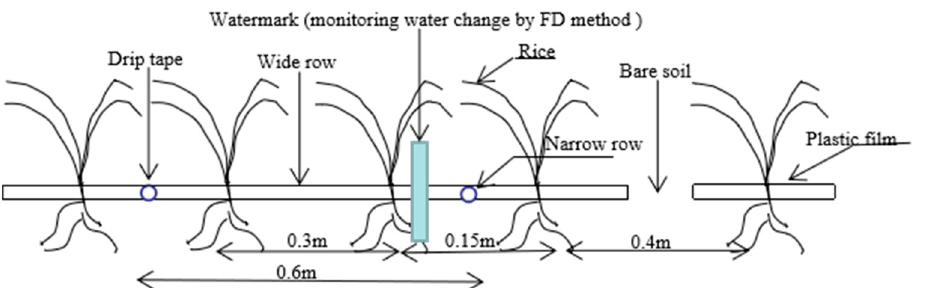
Figure 1. Rice planting pattern with drip irrigation and plastic film mulching.